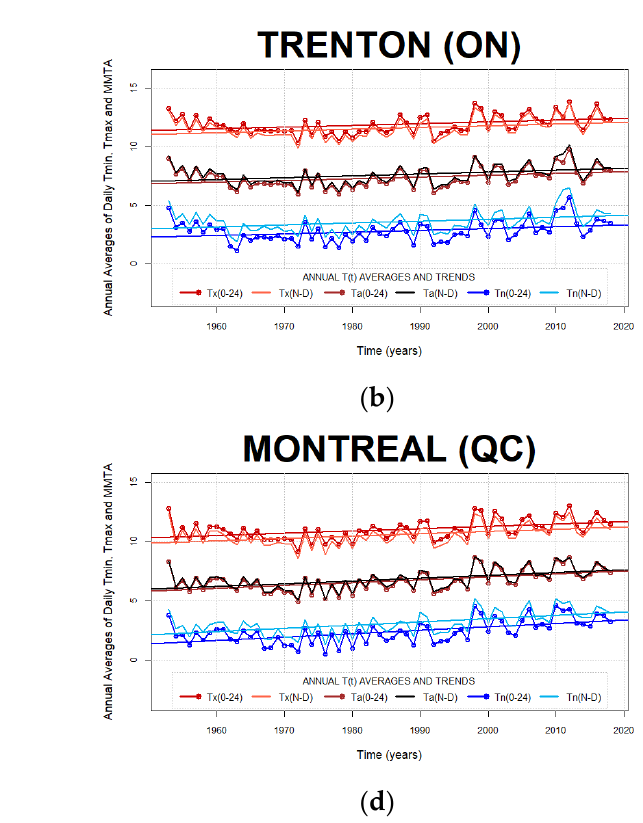
Table 3. Discrepancies between COW 0–24 and COW N–D annual averages of diurnal temperature in- dices. All temperature data examined in this study represent hourly measurements obtained from Canadian international or regional airports using consistent observation standards. Large differ- ences in temperature trends and discrepancies between individual data sets are the result of regional climate differences. Δ T min represents differences between COW 0–24 and COW N–D minima, while Δ T max represents differences between COW 0–24 and COW N–D maxima. MMA stands for Min-Max Averages, while DTR stands for the Diurnal Temperature Range.